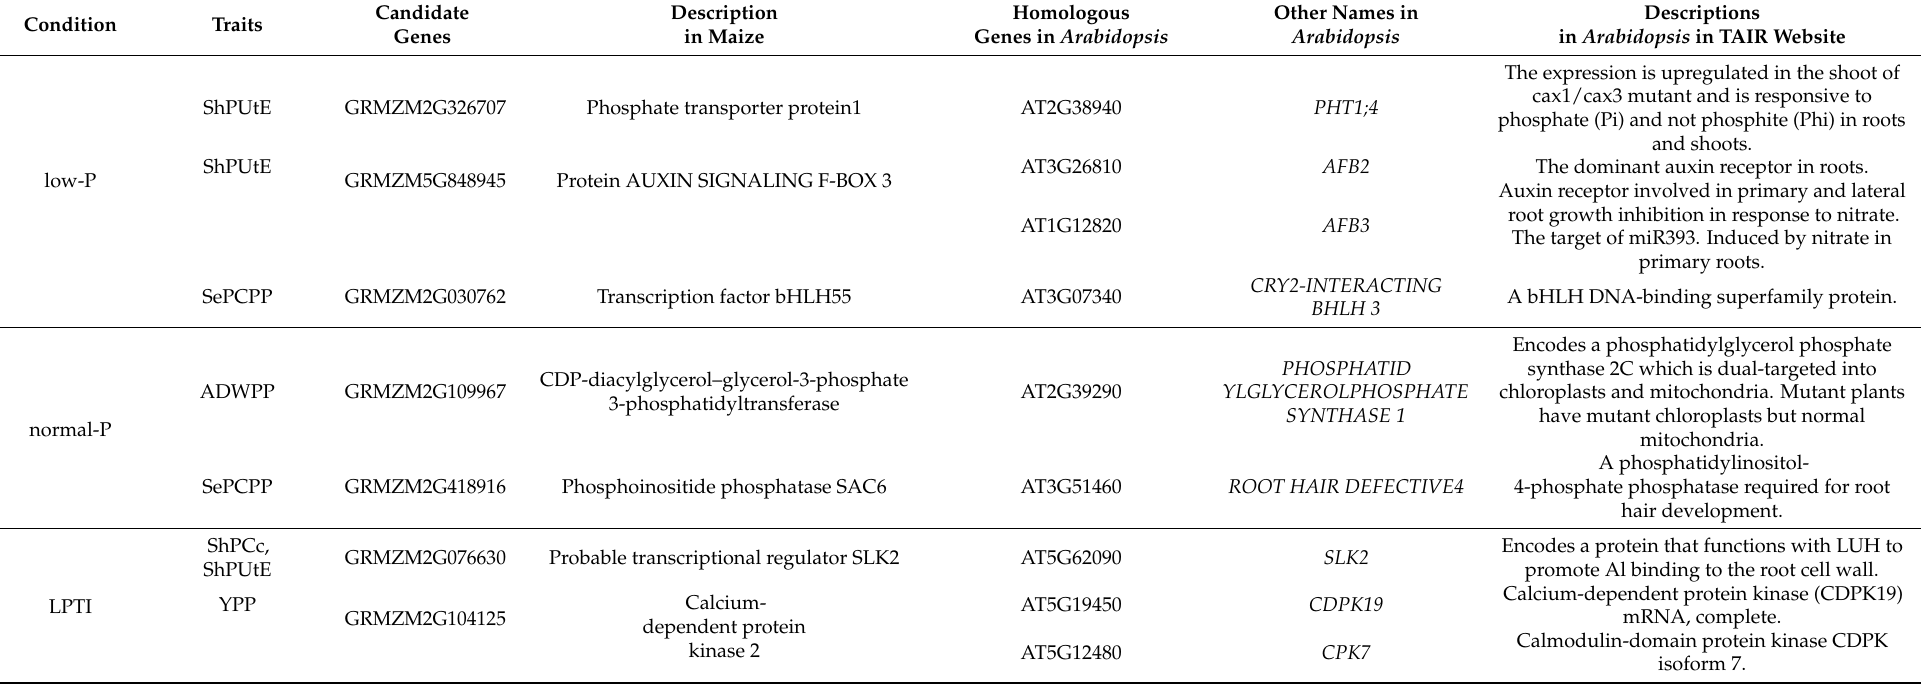
Table 2. Key candidate genes identified in the low-P, normal-P, and LPTI datasets, and homologous genes annotations in Arabidopsis thaliana